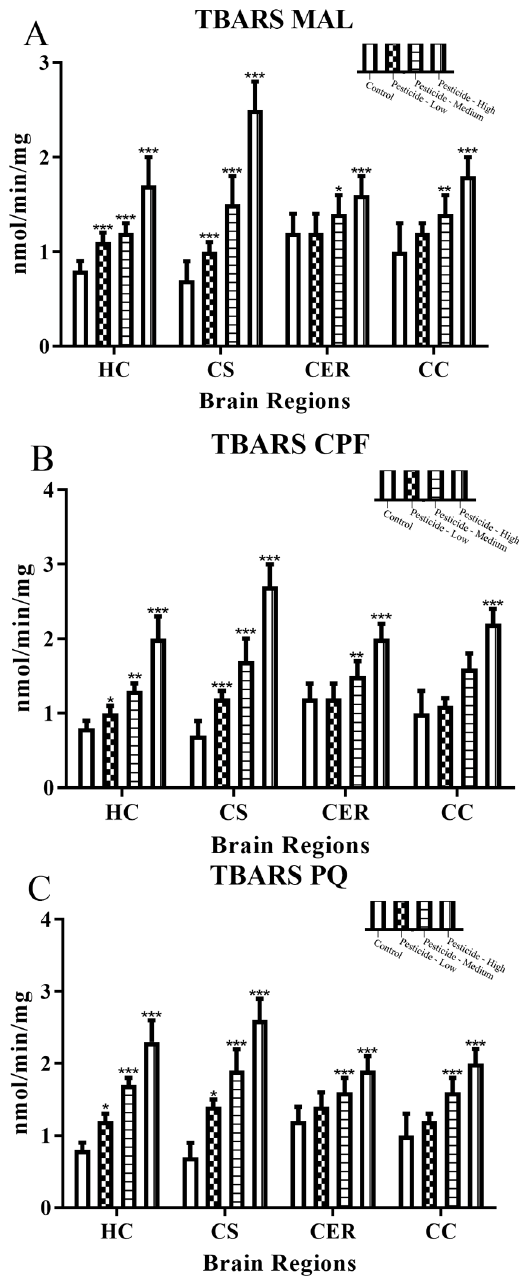
Figure 6. Pesticide induction of thiobarbituric acid reactive substances (TBARS). Rats were dosed with malathion (MAL) ( A ); chlorpyrifos (CPF) ( B ); or paraquat (PQ) ( C ); at low, medium, or high dosages and the levels of thiobarbituric acid reactive substances (TBARS) quantified within the hip- pocampus (HC), corpus striatum (CS), cerebellum (CER), and cerebral cortex (CC). Histograms are representative of mean values with SDs, with significant changes marked with asterisks, according to * p < 0.05, ** p < 0.01, and *** p < 0.001. Nuclear activation of the transcription factor Nrf2 promotes induction of cytoprotec- tive proteins in response to cellular stress, and nuclear Nrf2 levels increased according to pesticide dose (Figure 7A–C).